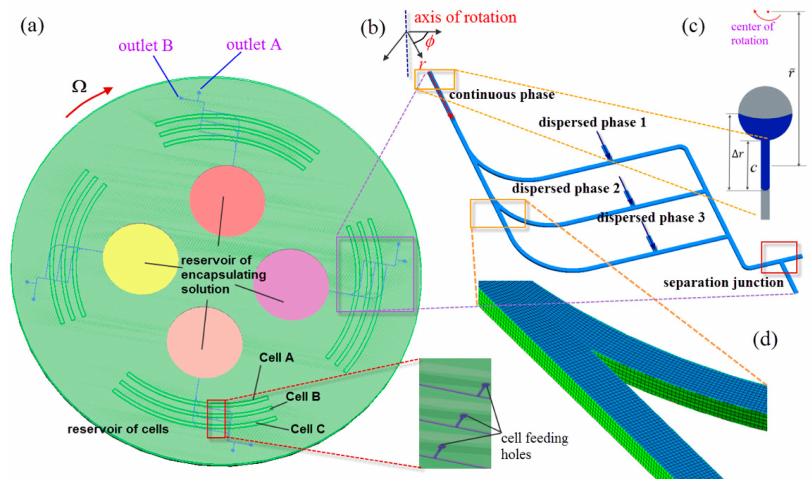
Figure 1. ( a ) Schematic of the centrifugal microfluidic device; ( b ) schematic of the computational domain of the multiphase centrifugal microfluidic microchannels; ( c ) close-up view of thread of continuous phase as indicated in blue progressing along microchannel after being pumped from the reservoir; and ( d ) close-up view of generated mesh grids of the bifurcated